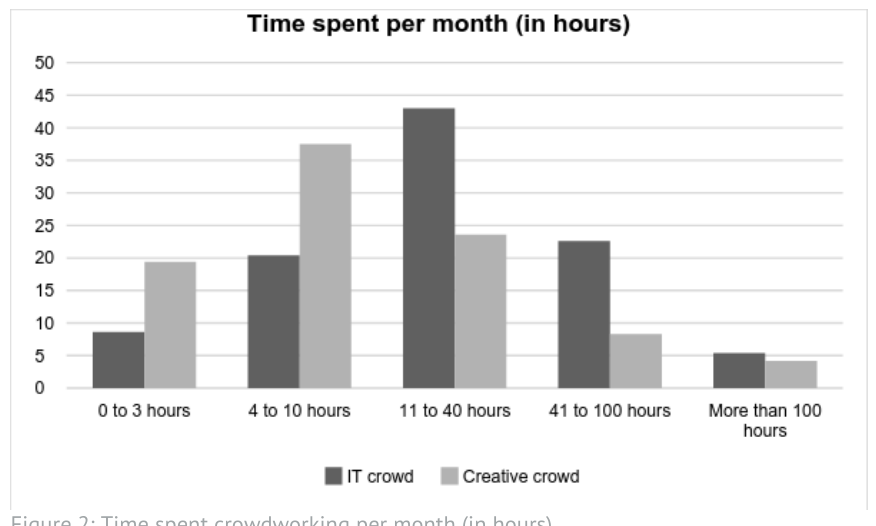
Figure 2: Time spent crowdworking per month (in hours) MOTIVATIONS OF